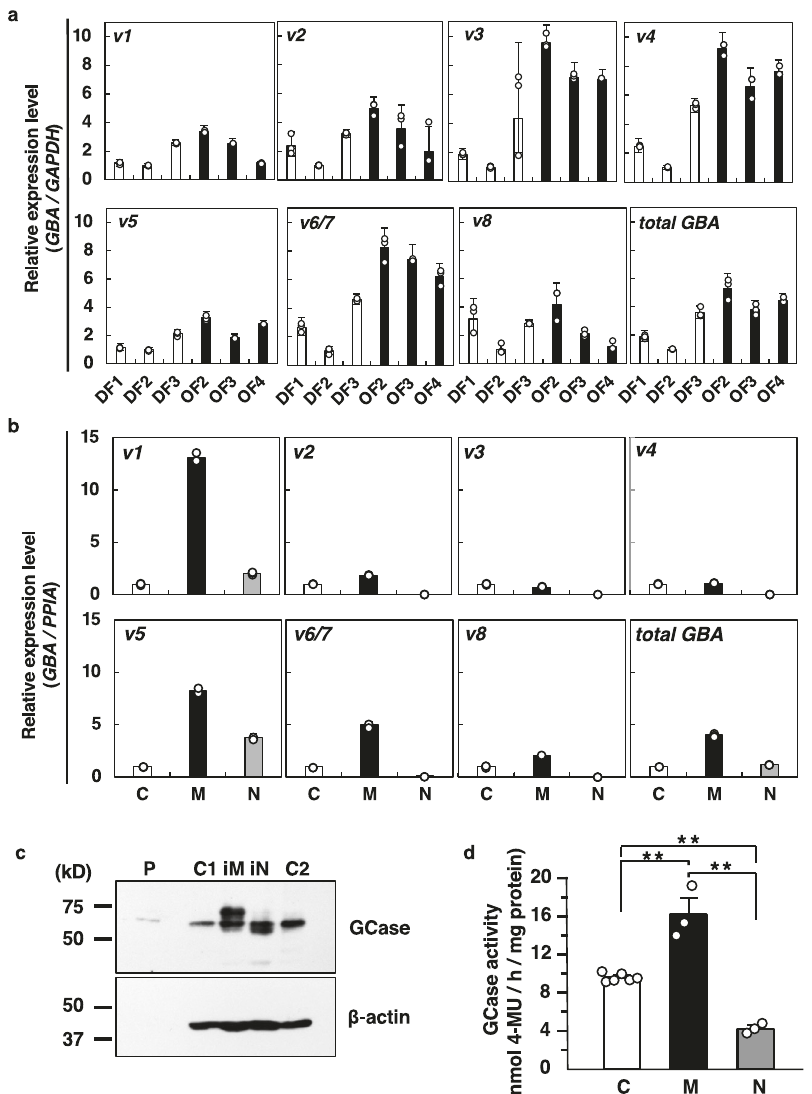
Fig. 4 Cell type-speci fi c expression of GBA variants. a Comparison of the expression levels of GBA transcripts in fi broblasts. The expression levels of GBA transcripts were normalized to those of GAPDH , and expressed as the relative quantity to that of DF2. Each experiment was performed in triplicate. DF, dermal fi broblasts; OF, oral mucosa fi broblasts. b Expression levels of GBA transcripts among different cell types using an in vitro hematopoietic differentiation system of HL60 cells. The expression levels of GBA were normalized to those of PPIA , and expressed as the relative quantity to that of control HL60 cells. Each experiment was performed in triplicate except v6/7 , N in v3 , C in total GBA were duplicate. C, control HL60 cells (no treatment); M, iMacs; N, iNeuts. c The expression levels of GCase protein by western blot analysis. Representative western blot analysis data is shown. C1 and C2, two individual controls (nontreated HL60 cells); M, iMacs; N, iNeuts, P, positive control (human GBA in pCIneo-transfected HEK293 cell lysate). d GCase activity. C, control HL60 cells (no treatment); M, iMacs; N, iNeuts. Each experiment was performed in triplicate except control (control, n = 6). ** p < 0.01. Data represent the mean ±